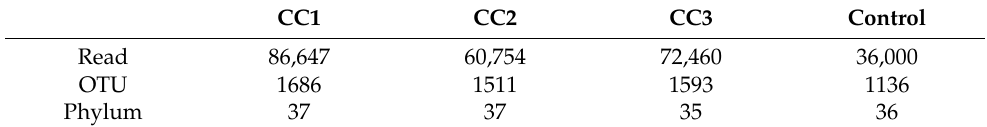
Table 1. Numbers of reads, operational taxonomic units (OTUs), and phyla on clear-cutting plots (CC1, CC2, and CC3) and the Control. The taxa estimated at the phylum level were treated as OTUs.